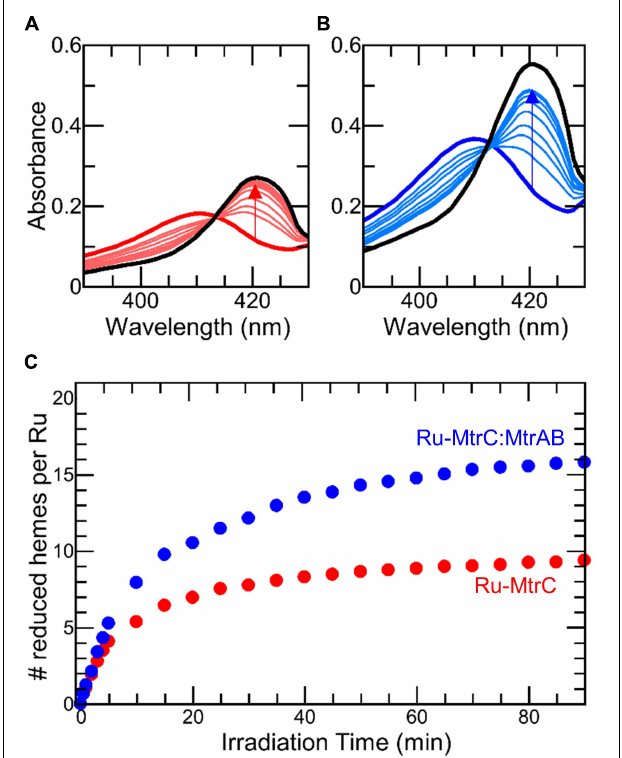
( Supplementary Figure 6E ). The DAMMIN models of the Ru-